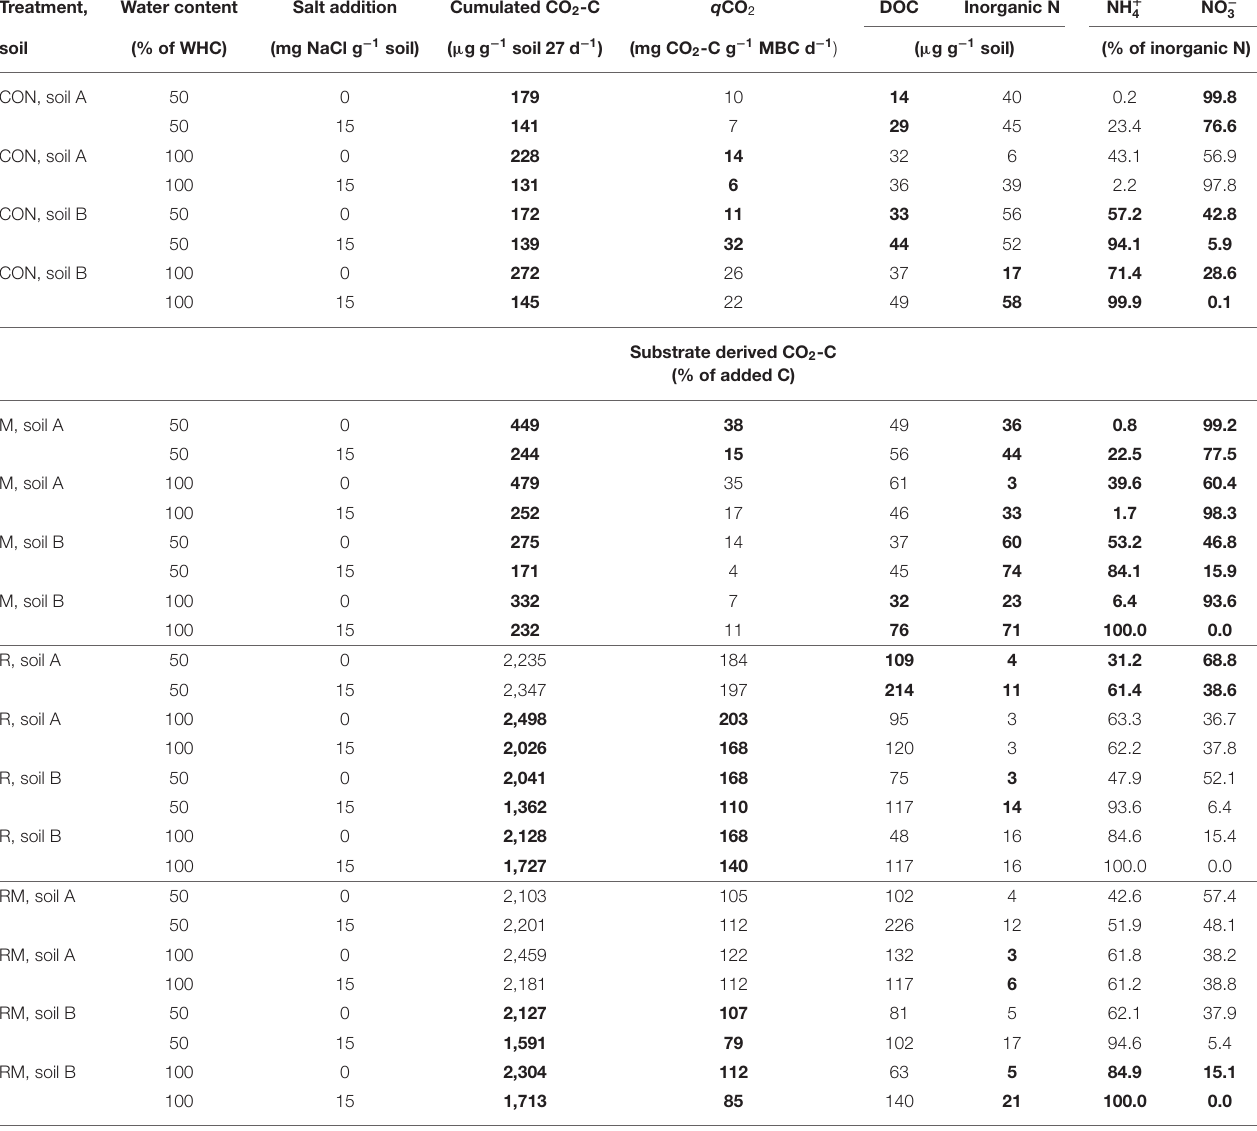
TABLE 1 | Cumulated respiration, dissolved organic C (DOC), inorganic N, the proportion of ammonium (NH + 4 ) and nitrate (NO − 3 ) on inorganic N for the unamended treatments (CON), the manure (M), the rice straw (R) and the rice-straw plus manure (RM) treatments.